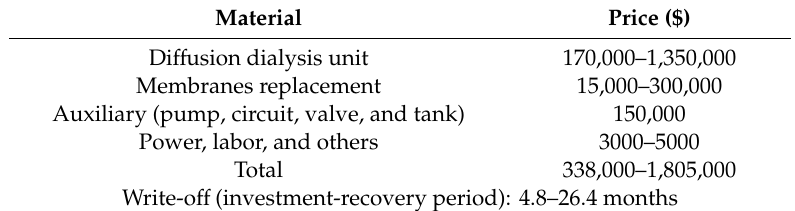
Table 2. The economic investment of the DD system using AEMs for acid recovery [13,22,33,34].